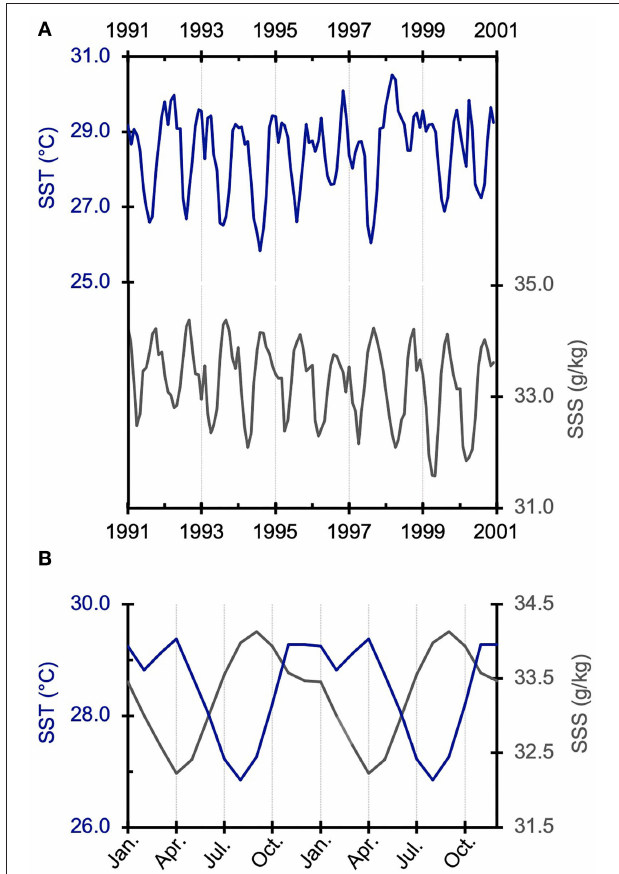
FIGURE 2 | (A) SST and SSS in Lombok Strait from 1991 to 2000, covering the El Niño and IOD events occurred in 1994 and 1997. (B) Seasonal variation of monthly average SST (dark blue line) and SSS (gray line) for the period 1991–2000. SST data were obtained from IGOSS (115.5 ◦ E, 8.5 ◦ S) and SSS data from SODA (115.75 ◦ E, 8.25 ◦